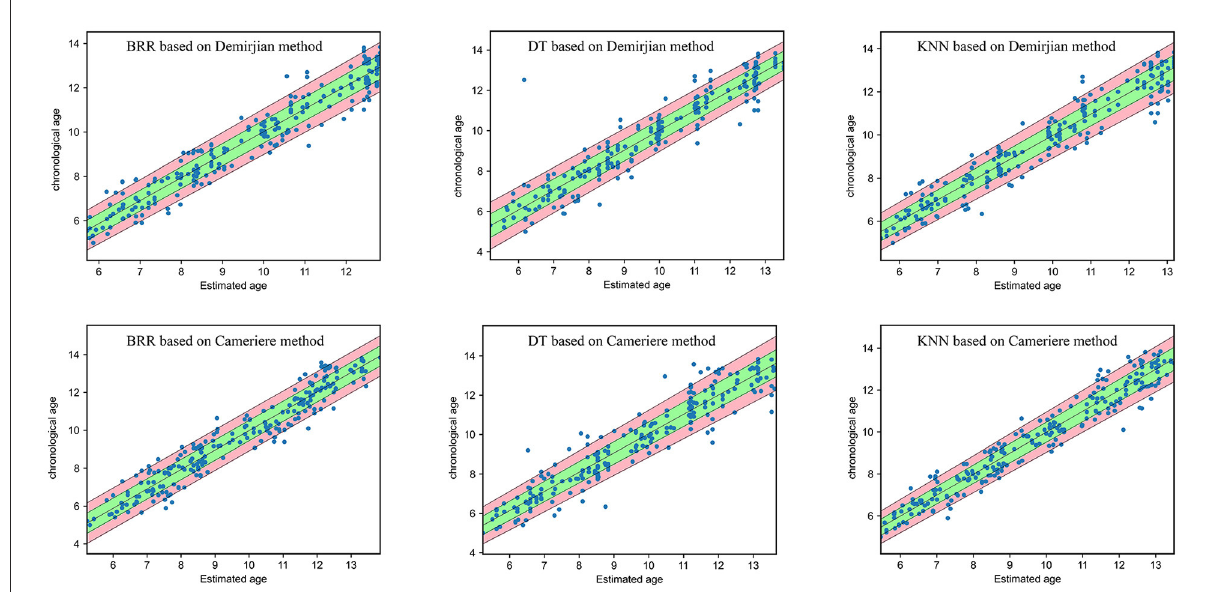
FIGURE3 The model performance for different machine learning algorithms (DT, decision tree; BRR, Bayesian ridge regression; KNN, k-nearest neighbors) based on Demirjian or Cameriere method. Green area: dental age ± δ ; red + green area: dental age ± 2 δ ; ideal line: chronological age = estimated dental.